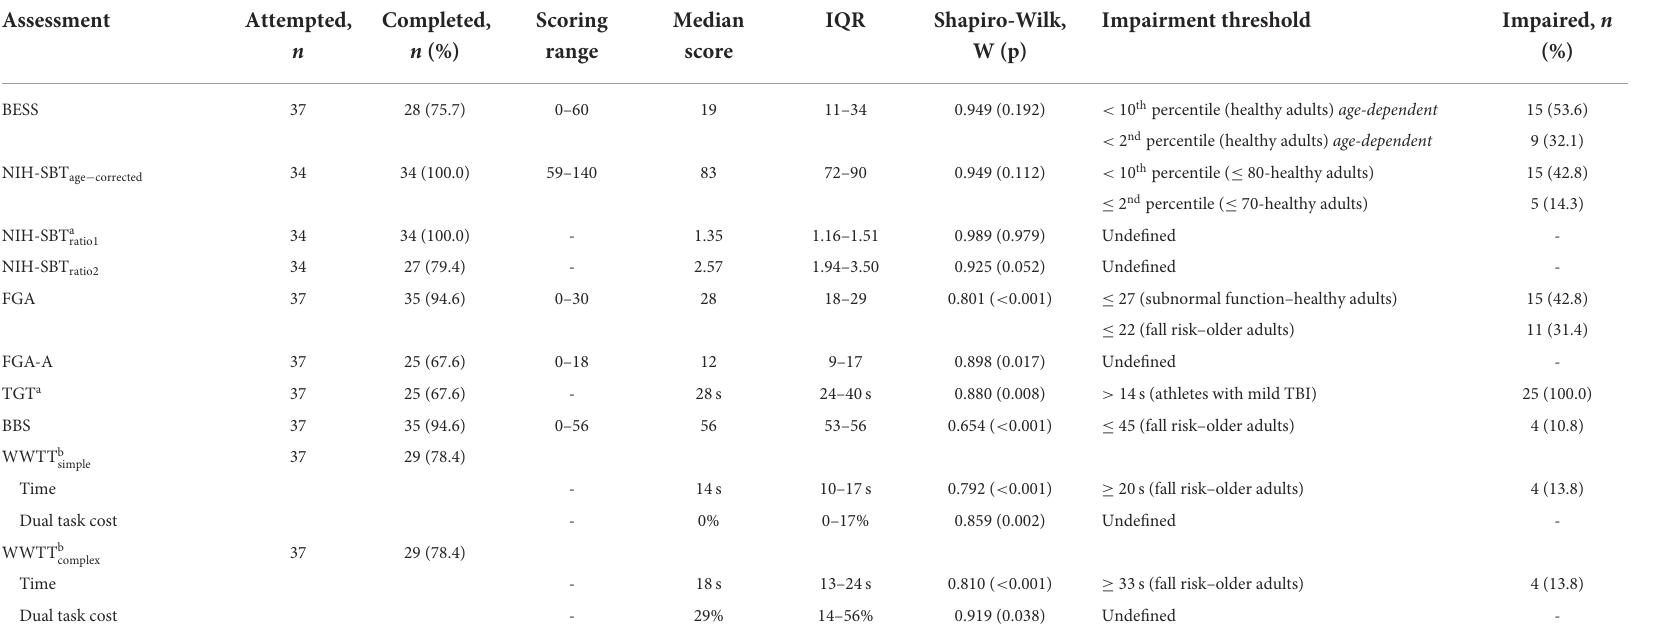
TABLE 4 Descriptive summary of clinical balance assessment feasibility and test